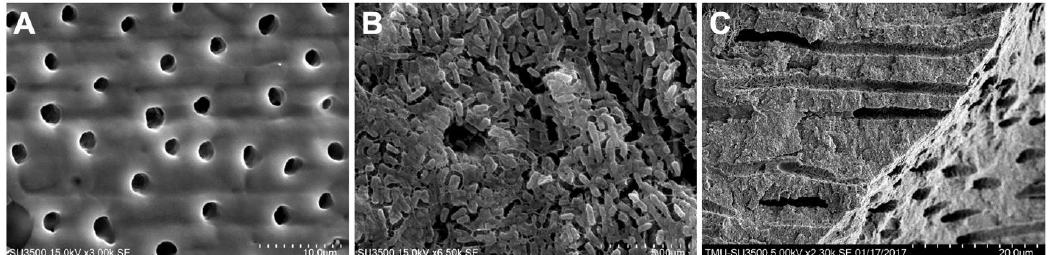
Figure 4. SEM images of the control dentin disc surface, ( A ) dentin disc surface with open dentin tubules; ( B ) dentin surface with 7-day P. gingivalis biofilm; ( C ) longitudinal dentin tubules of control dentin disc.